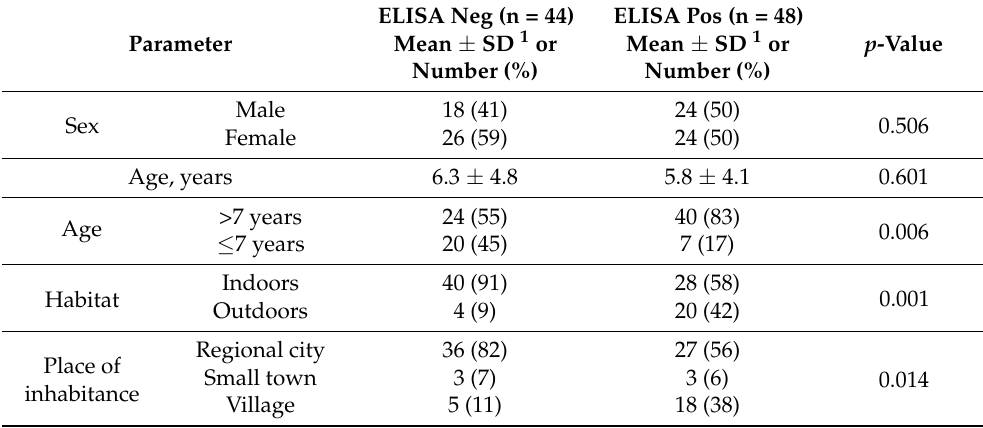
Table 1. SARS-CoV-2 seroprevalence in 92 serum samples obtained from domestic and stray cats according to sex, age and place of